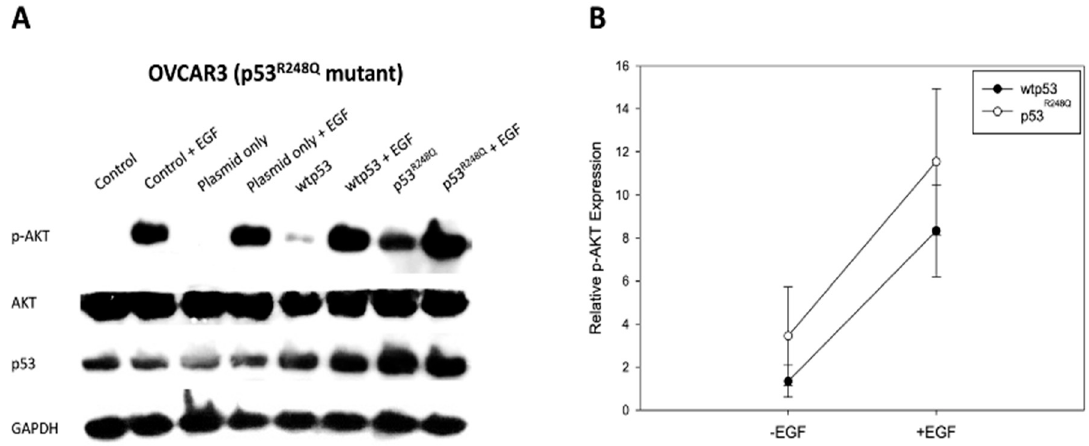
Figure 1. p53 R248Q resulted in regulation of p-AKT. ( A ) The level of p-AKT was increased after p53 R248Q overexpression in OVCAR3 cells. It should be noted that OVCAR3 cells were transiently transfected with either empty plasmid (1 μ g/mL), wtp53 (1 μ g/mL), or p53 R248Q (1 μ g/mL) for 24 h and then stimulated with EGF for 15 min. GAPDH expression was measured to serve as a loading control. ( B ) The band intensity of the immunoblots was quantified using ImageJ software. The relative intensities of p-AKT expression were normalized with the control group. (wtp53: wild-type p53 plasmid; p53 R248Q : p53 R248Q mutation plasmid).